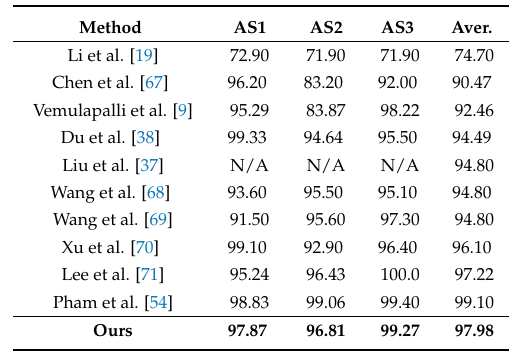
Table 2. Test accuracies (%) on the MSR Action3D dataset [19]. Please note that many previous methods are based on depth sensors.